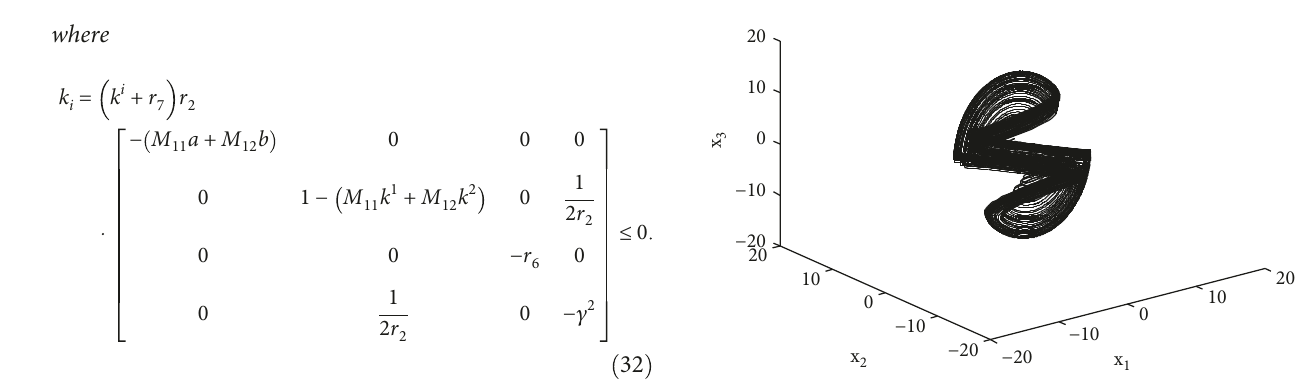
Figure 2: Attractor of the memristive chaotic